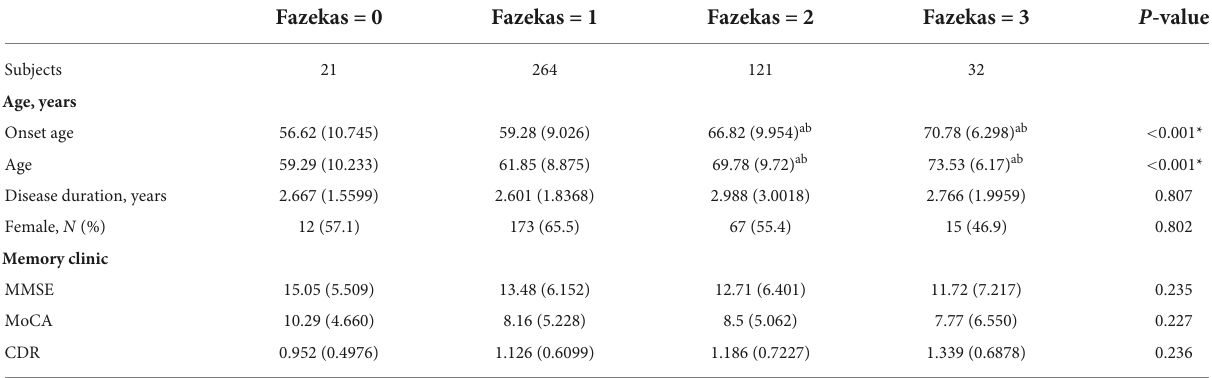
TABLE 5 Demographic features and Fazekas of the samples.